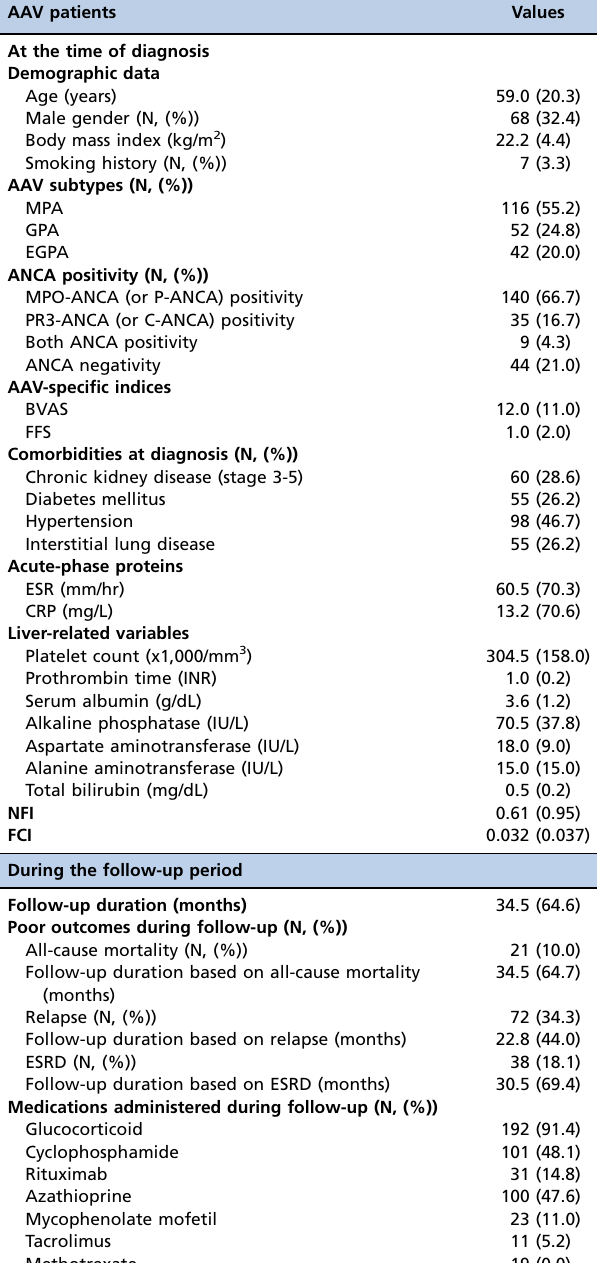
Table 1 - Characteristics of AAV patients at diagnosis and during follow-up